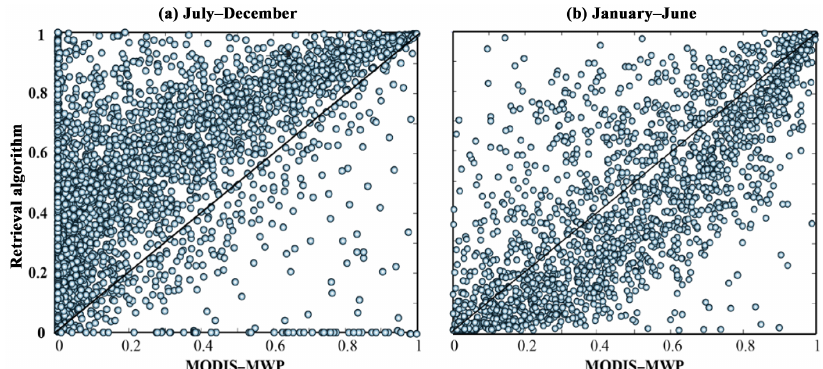
Figure 7. Scatterplots of daily inundation fractions ( f ) from the retrieval algorithm against those from MODIS-MWP in wet (a) and dry seasons (b) shown in Fig. 6. The scatterplots demonstrate larger inundation fractions from the retrieval algorithm in July to December (a) compared to MODIS-MWP data. However, in January to June, when there are fewer clouds, the inundation fractions from the proposed algorithm are more correlated with the MODIS-MWP data, with only a slight underestimation of their